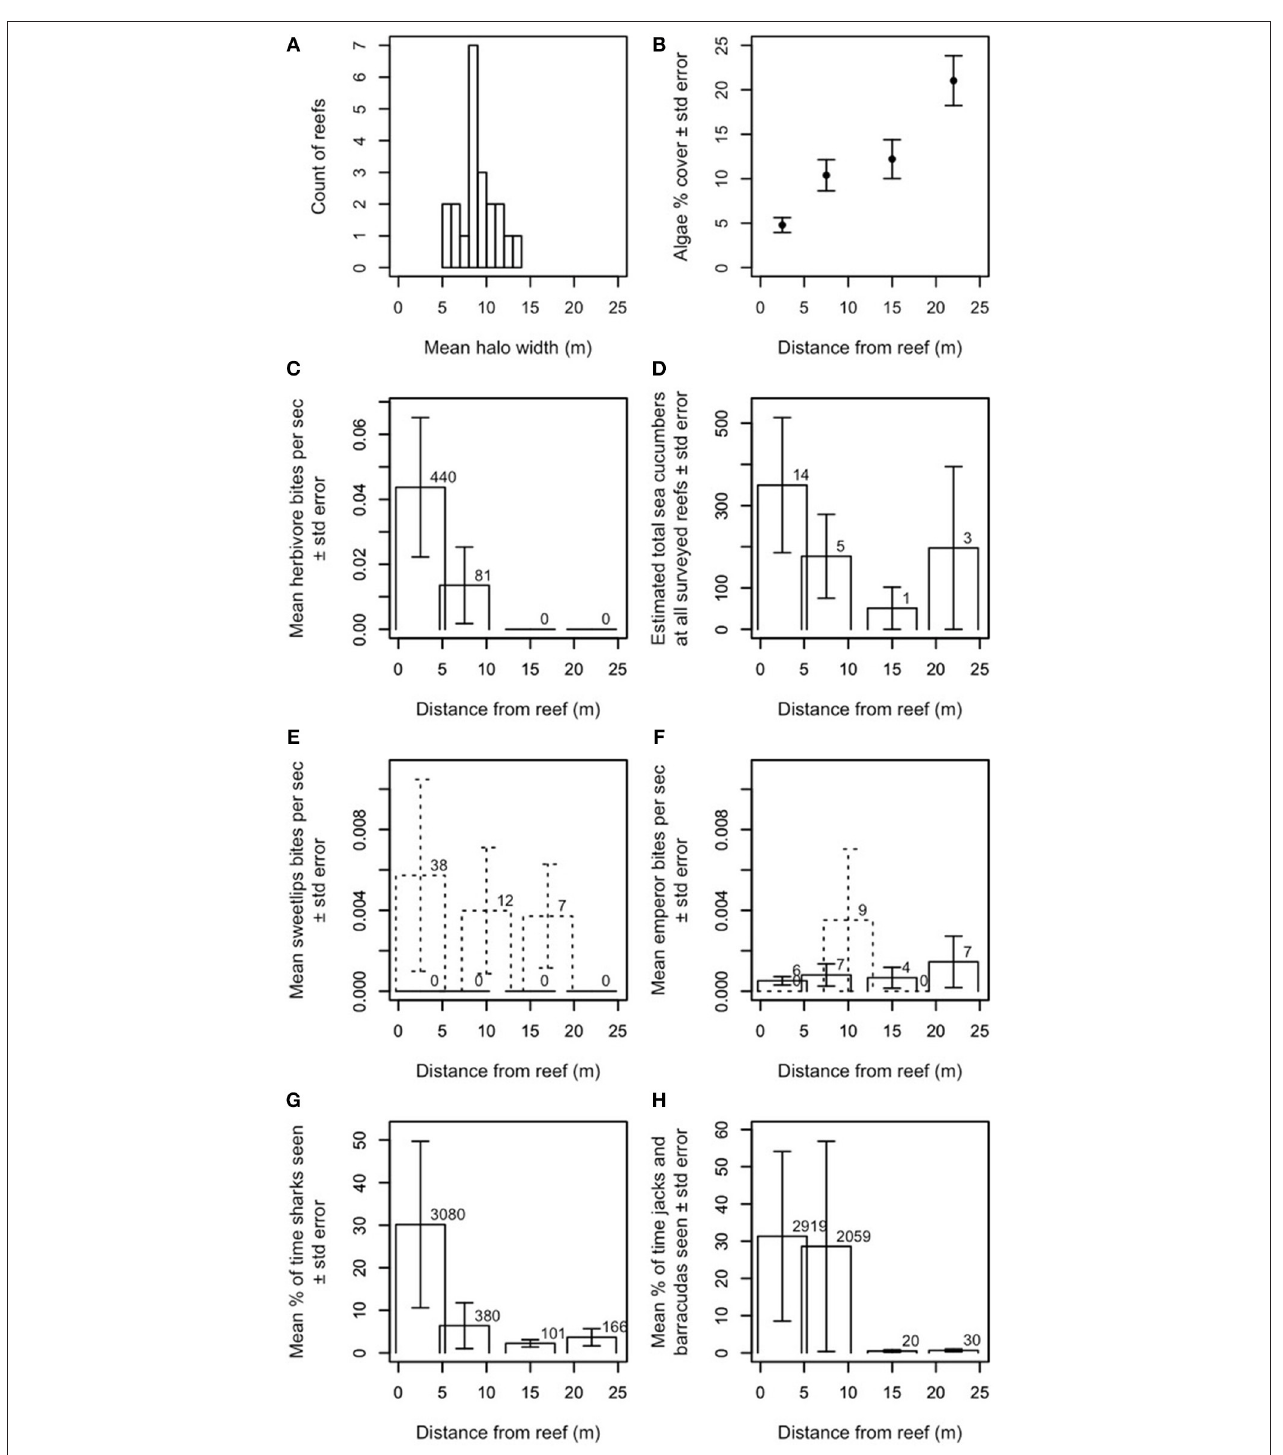
FIGURE 1 | Ecological characteristics of halos and contributors to halo formation. (A) Approximate widths of halos at Heron Island, measured from satellite images, and averaged over time. Twenty-one reefs are included because three of the 24 reefs used in the study never had measureable halos in the satellite images. (B) Average benthic algal cover in 2013 surrounding the 22 study reefs where in-situ data could be collected relative to distance from the reef. (C) Mean aggregate bite rate of herbivorous fishes by distance from the reef (number above bar indicates N bites observed). Herbivorous fishes were seen in our dusk/night dataset, but were never observed feeding. (D) Estimated total number of sea cucumbers at all surveyed reefs by distance from the reef (number above bar indicates N individuals